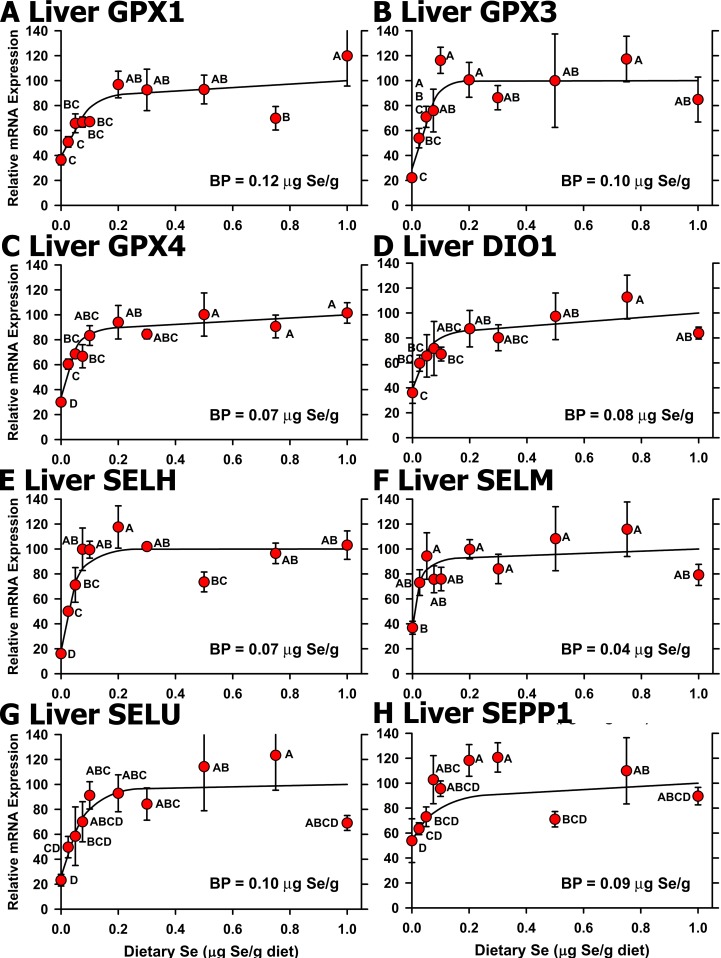
Effect of dietary Se on significantly-regulated selenoprotein transcript level in chick liver.Relative transcript levels are plotted for GPX1 (A), GPX3 (B), GPX4 (C), DIO1 (D), SELH (E), SELM (F), SELU (G) and SEPP1 (H) in chicks supplemented with the indicated levels of dietary Se for 29 d. Values were determined in triplicate for each sample, normalized to the mean of GAPDH and ACTB levels in each sample, expressed as a percentage of Se-adequate plateau levels, and plotted as mean±SEM (n = 4/treatment). Means without a common letter are significantly different (P<0.05). Overall level of significance, as determined by ANOVA, is given in Table 3. Se response curve breakpoints (BP) are indicated in each panel, calculated as described in the text.